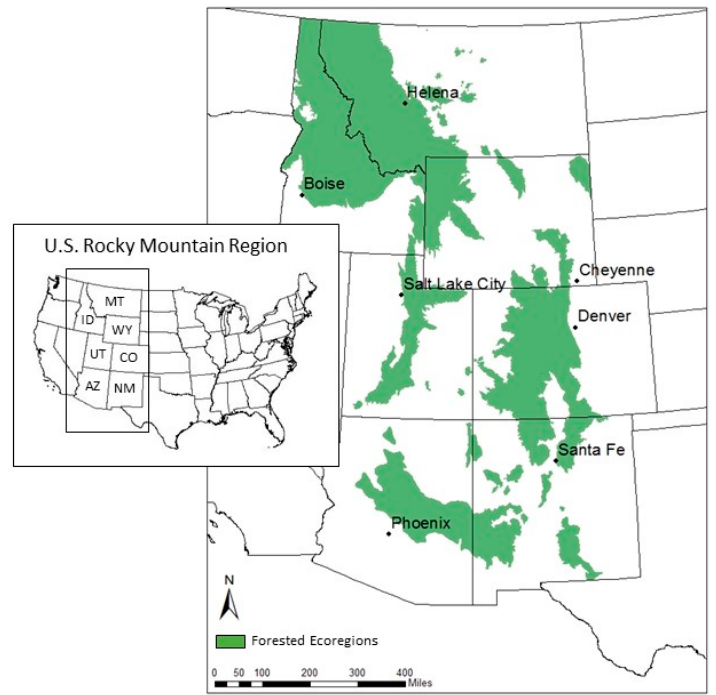
Figure 1. Study area map.